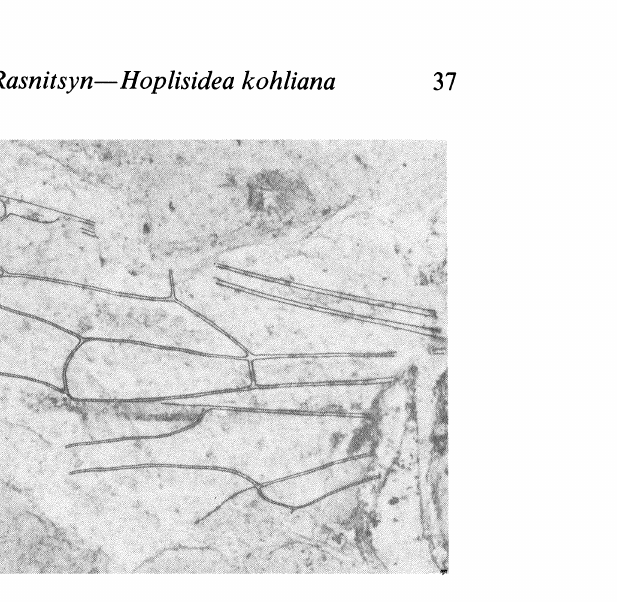
Fig. 2. Photograph of wings of Hoplisidea with veins inked in for